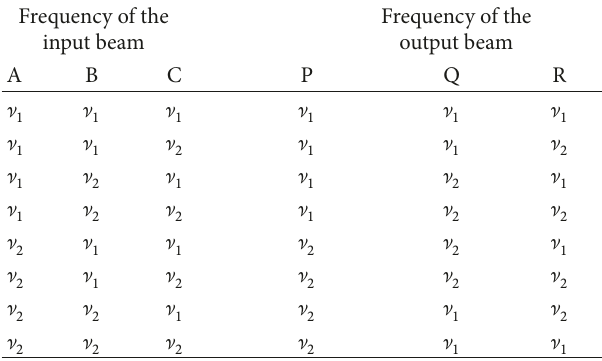
Table 2: Truth table of frequency encoded Peres